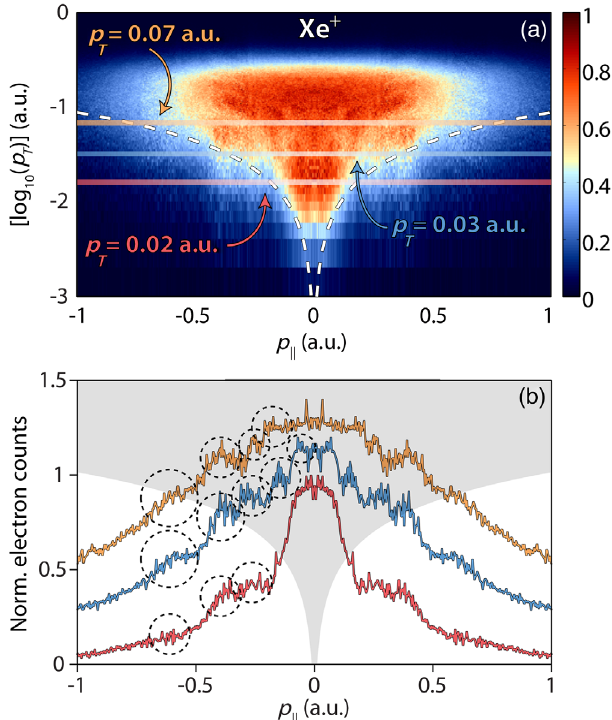
FIG. 9. (a) The measured electron momentum distribution corresponding to Xe þ after interacting with an intense 71-fs, 3 . 1 - μ m pulse with a peak intensity of I ¼ 4 × 10 13 W cm − 2 ( γ ¼ 0 . 4 ). The data are symmetrized with respect to p ∥ ¼ 0 . Lineouts at three values of p ⊥ are presented in (b) to highlight the different LES orders and the VLES (black dashed circles). The white dashed line in (a) represents the acceptance cone of a TOF spectrometer with Θ A ¼ 5 °, which roughly precludes the detec- tion of the features within the gray shaded region in (b).